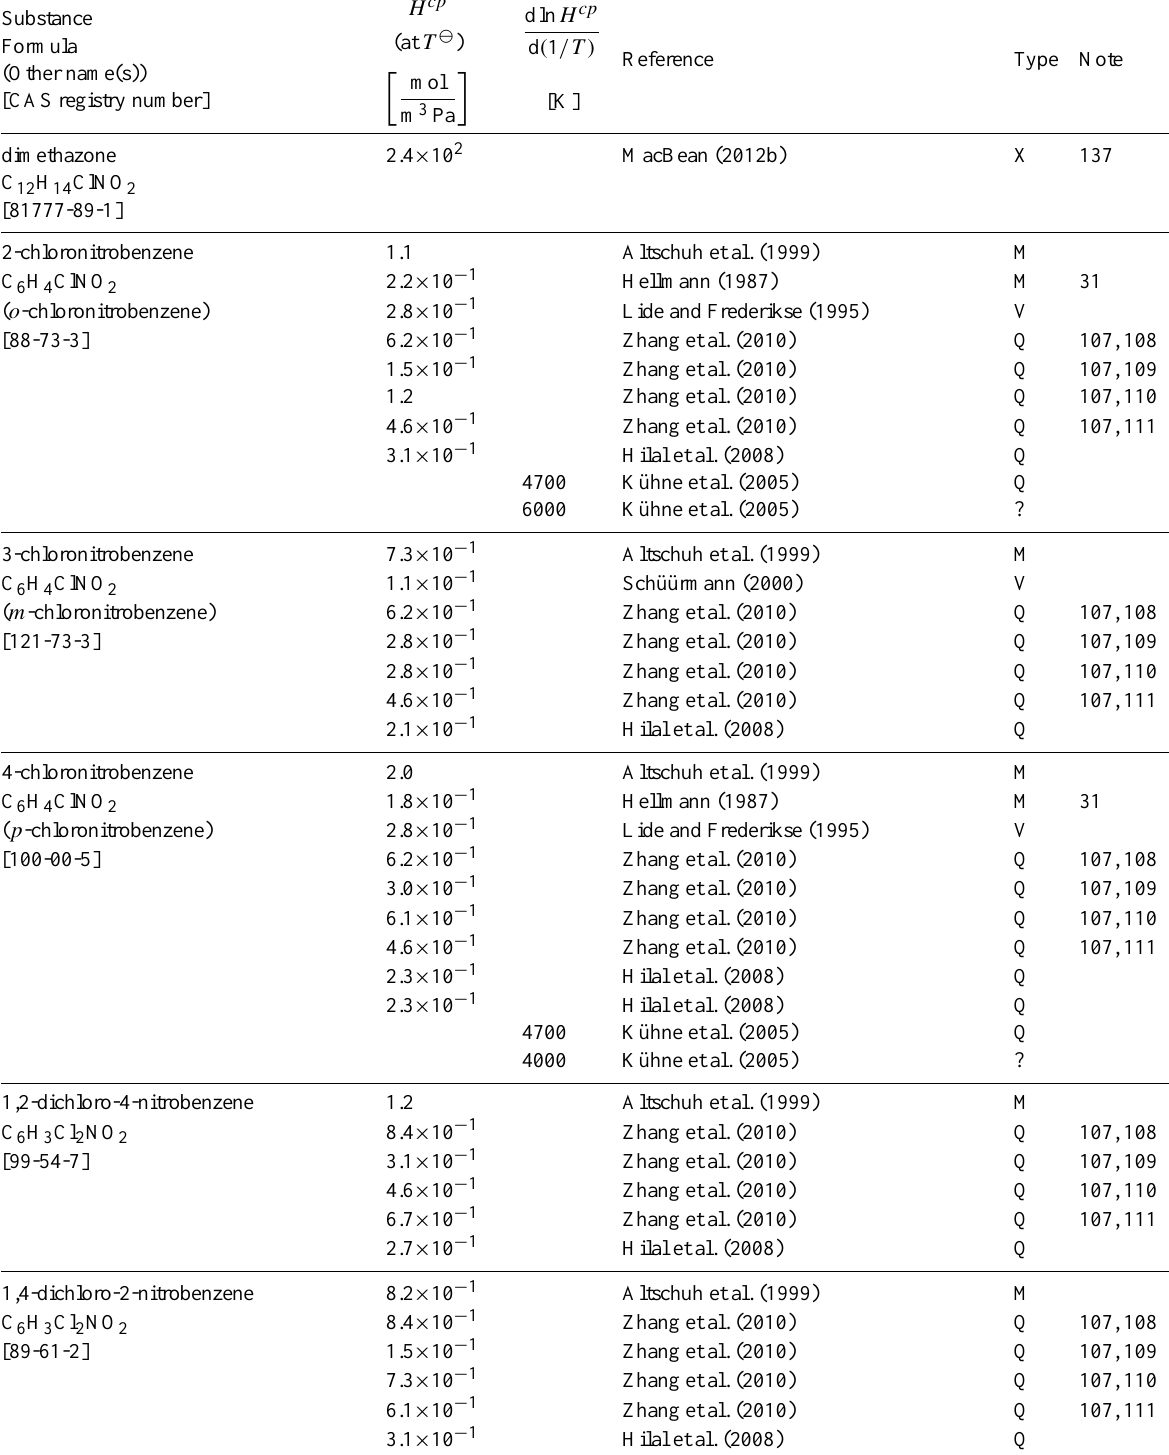
Table 6: Henry’s law constants for water as solvent